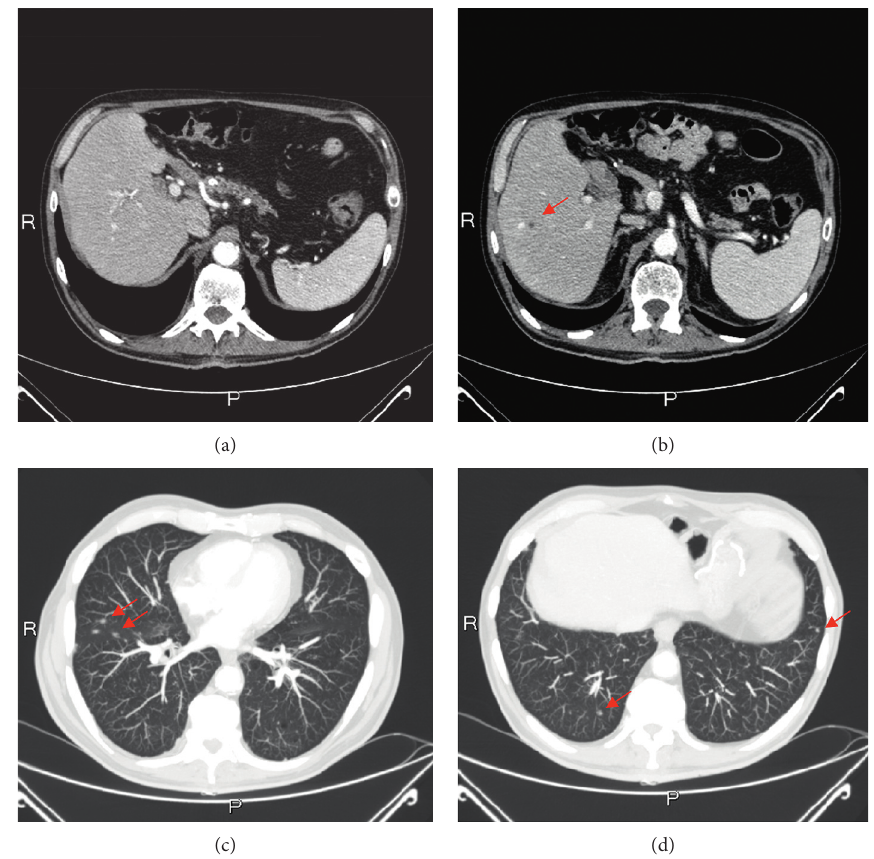
Figure 4: Disease relapse: radiological evaluation of primary pancreatic lesion (a), liver (b), and lung metastasis (c-d). The red arrows indicate the metastatic